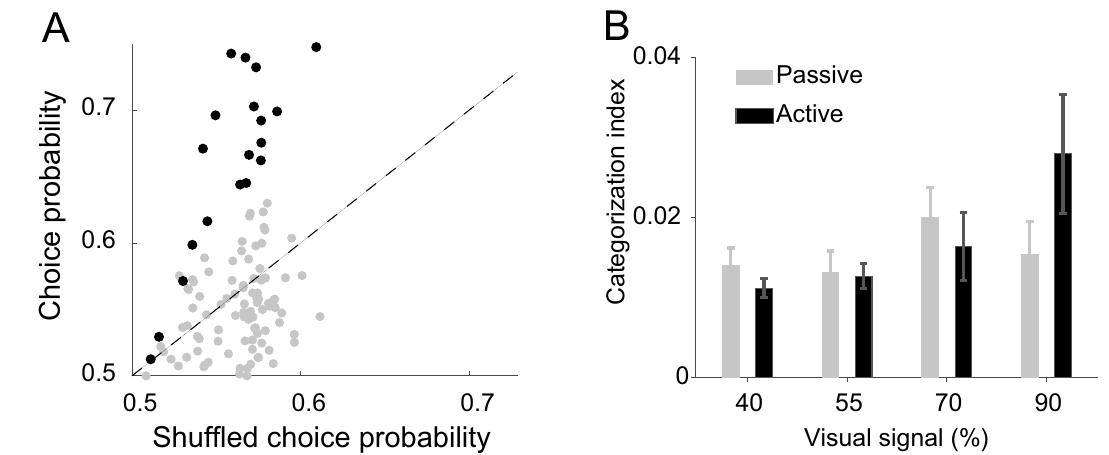
Figure 9. Choice probability computed for full noise stimuli. ( A ) Comparison of the CP and mean of shuffled CP for all IT neurons. The solid dots show neurons with significantly high CP values. ( B ) Bar plots show the mean value of CI during 150 to 350 ms after stimulus onset for neurons with high CP values in the passive and active trials. Error bars represent the SE of means in individual